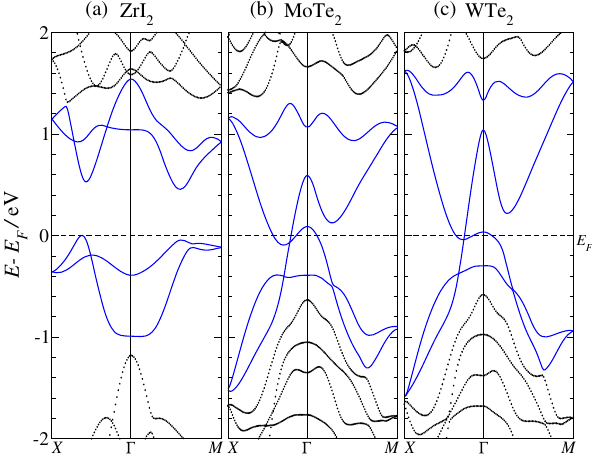
FIG. 3. DFT band structures of monolayer ZrI 2 (a), MoTe 2 (b), and WTe 2 (c) calculated without spin-orbit coupling. Bands close to the Fermi level have been plotted in blue to emphasize the different connectedness of the bands between ZrI 2 and MoTe 2 or WTe 2